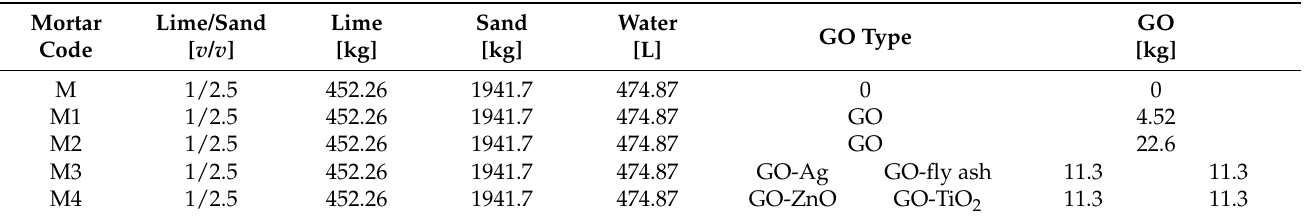
Table 1. The quantity of lime, sand, water, and GO-based powders as kg for m 3 in the control sample and experimental